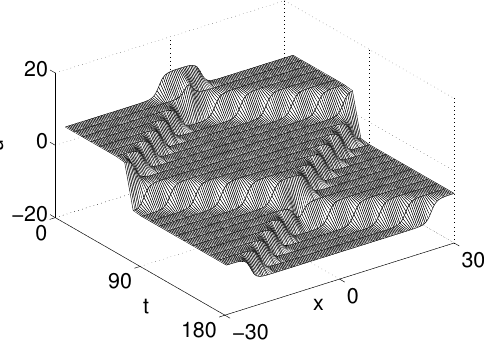
Figure 3. The numerical solutions from t = 0 to t = 200 with τ = 0.02 and h = 0.2.